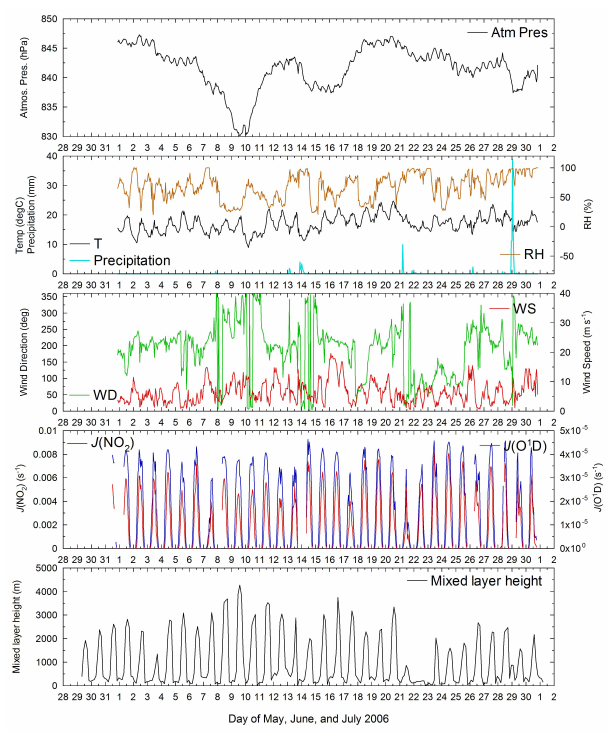
Fig. 2. Time series of atmospheric pressure, temperature, RH, pre- cipitation, wind direction and speed, J (NO 2 ) , and J (O 1 D) values, and mixed layer